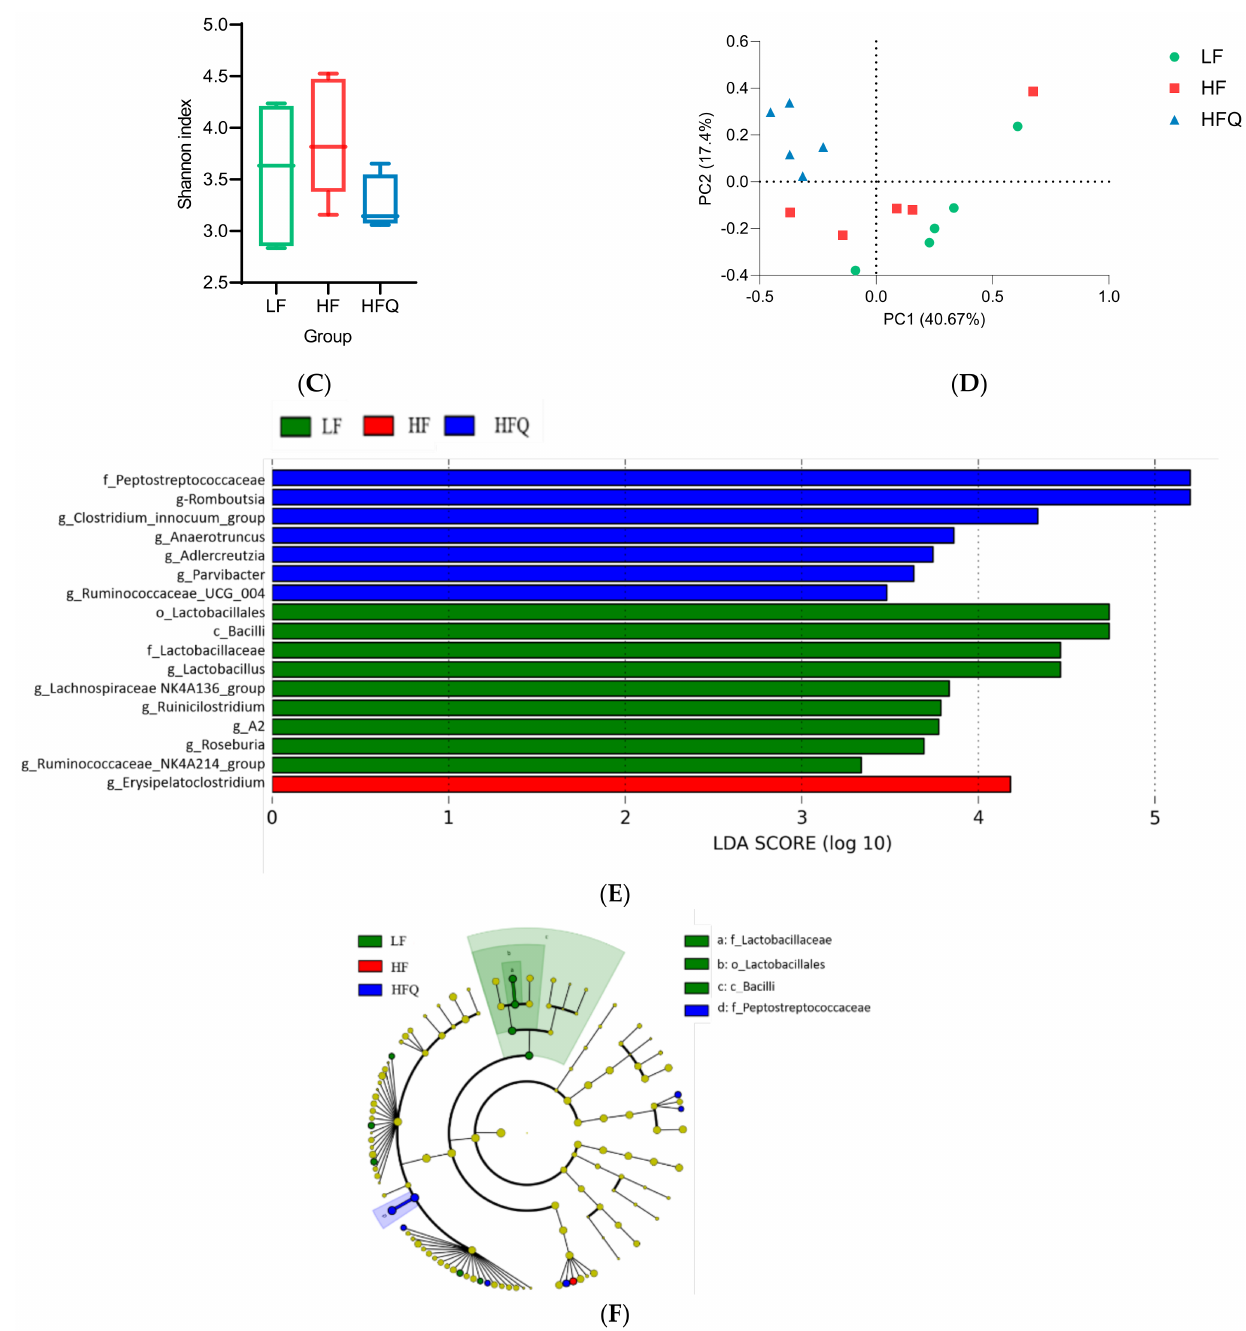
Figure 5. ( A ) Effect of 0.05% quercetin on the relative abundance of the four most abundant bacterial phyla ( n = 5) in LF (low − fat), HF (high − fat), and HFQ (high − fat with 0.05% quercetin) diets. ( B ) Firmicutes/Bacteroidetes ratio of HF, HFQ, and LF diets for 6 weeks. ( C ). The alpha − diversity was assessed by calculating the Shannon index. ( D ) The beta − diversity was calculated by principal coordinate analysis (PCoA) for the visualization of pairwise community dissimilarity (Bray − Curtis index) of the microbial community. ( E ) Results of linear discriminative analysis (LDA). ( F ) Effect size (LefSe) analysis among three groups. Cardiogram showing differentially abundant taxonomic clades with an LDA score of 3.0 among groups with a p − value of 0.05; n = 5/group. An asterisk (*) indicates a significant